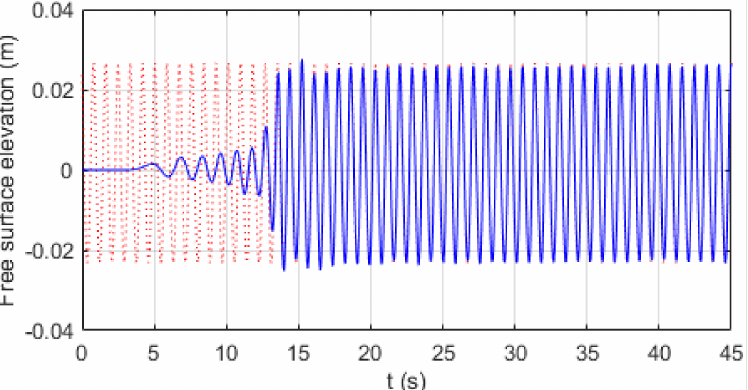
Figure 7. Sinusoidal wave with 0.05 m height, 0.85 s period, and 1.12 m wavelength, propagating in a channel of 0.56 m depth. Comparison of the analytical Stokes 2nd-order solution in Equation (46) (red dotted) with the numerical results obtained in a probe installed at x = 10.0 m (blue